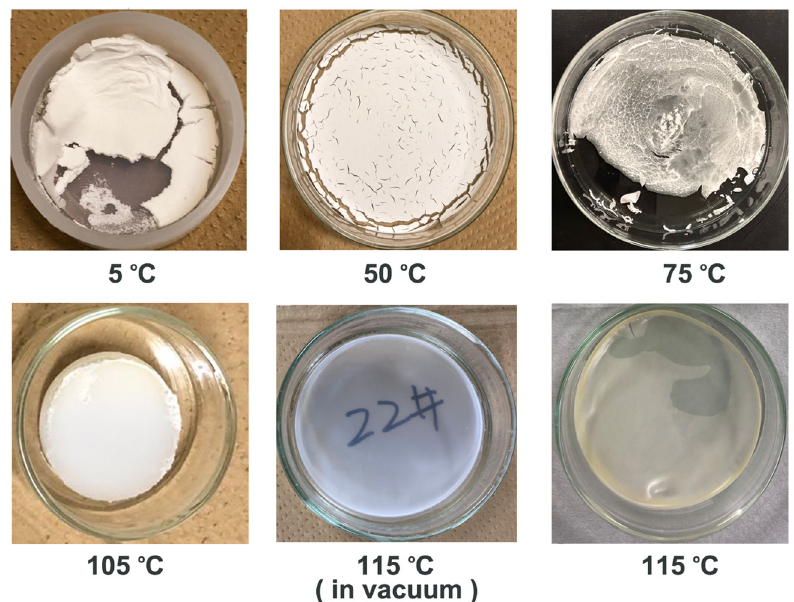
Figure 1: Casted ZnO NP ( 4% ) /LDPE fi lms formed at di ff erent casting